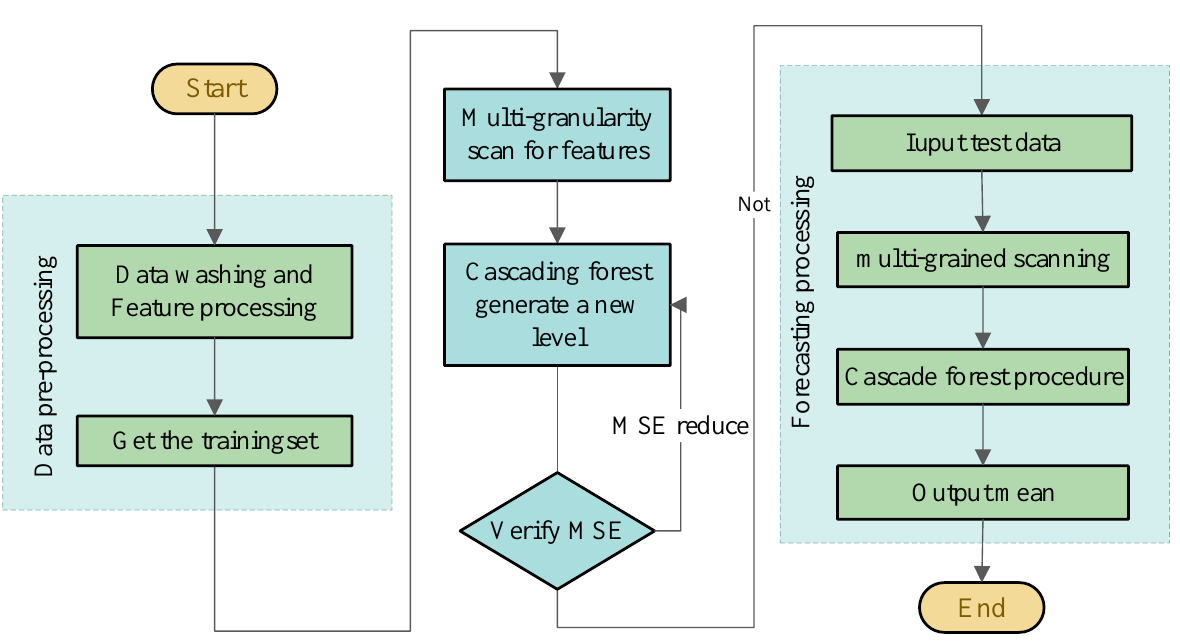
Figure 5. Flow chart of deep forest model. The transformed feature vectors after multigranularity scanning are used as the orig- inal feature vector X at one level in the cascade forest. X through each DTS in the subforest generates the regression vector the cascade forest, and t represents the t -th subforest module).